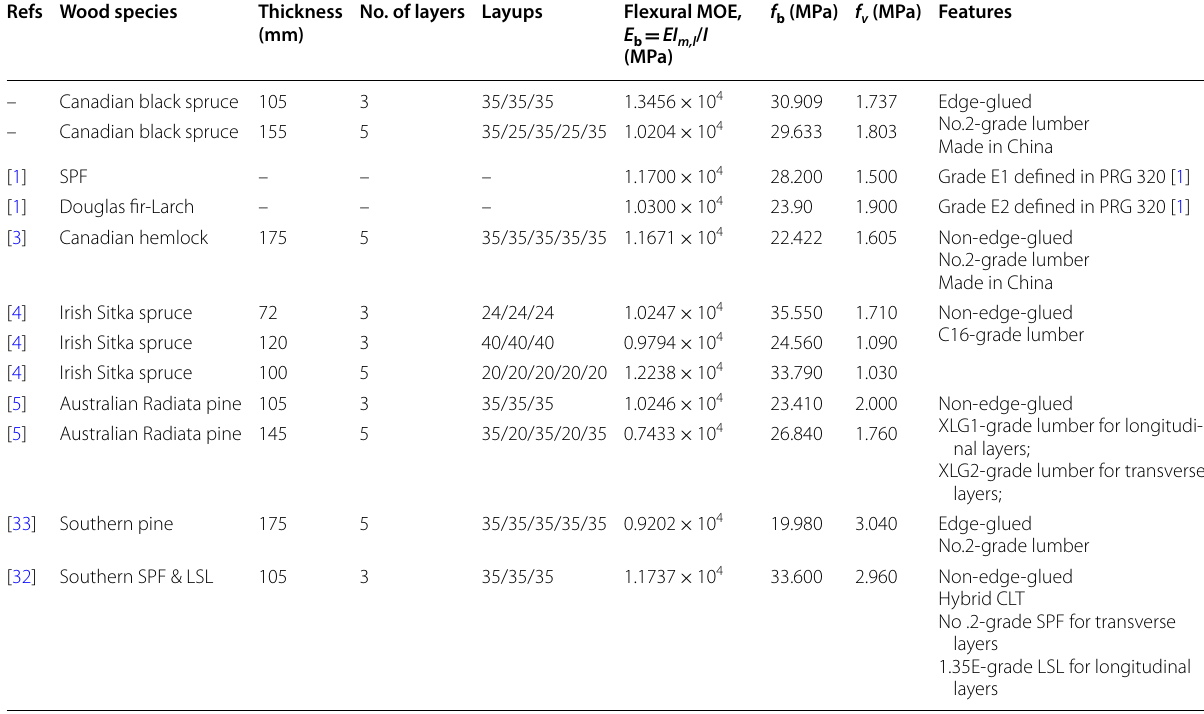
Table 10 Mechanical properties of CLT panels fabricated with different wood species Refs Wood